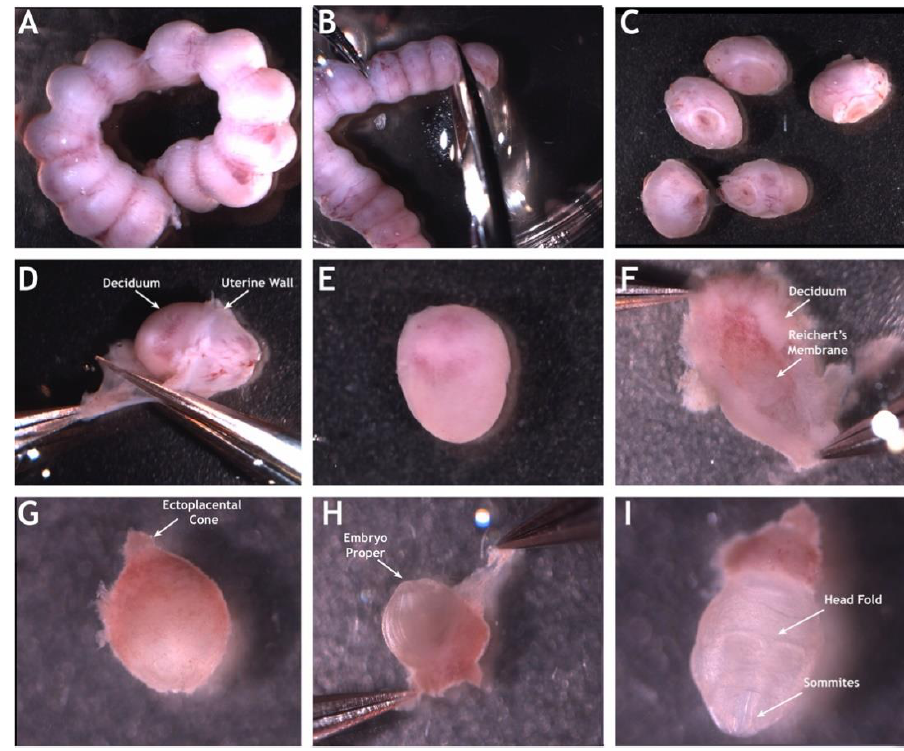
Figure 1. Mouse E8.5 embryo dissection for OCT imaging in static culture. The uterine horn is dissected from the female and separated into individual embryos ( A – C ). The uterine wall is peeled away exposing the embryo encapsulated in deciduum ( D , E ). The deciduum is peeled away exposing the embryo proper within Reichert’s membrane ( F – H ). Panel ( I ) shows the embryo proper attached to its ectoplacental cone. The embryo proper with its intact yolk sac exhibits the open head stage indicating the embryo is E8.5 ( I ). Reproduced with permission from [17].